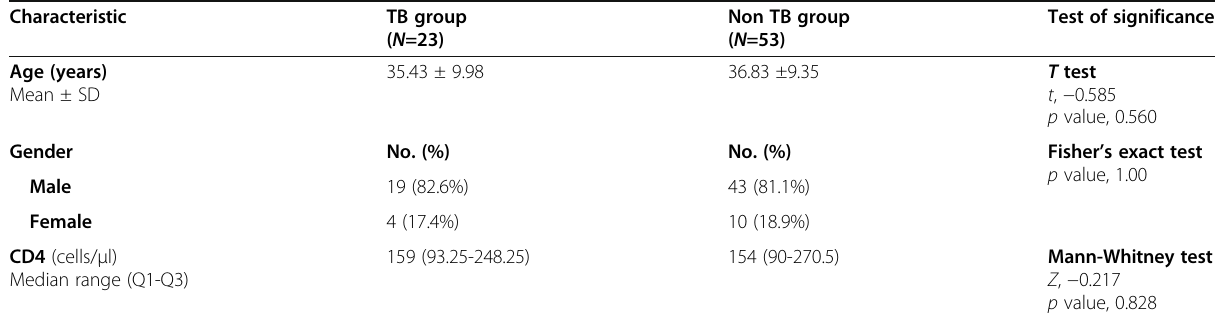
Table 2 Demographic data and CD4 characteristics of TB and non TB groups Characteristic